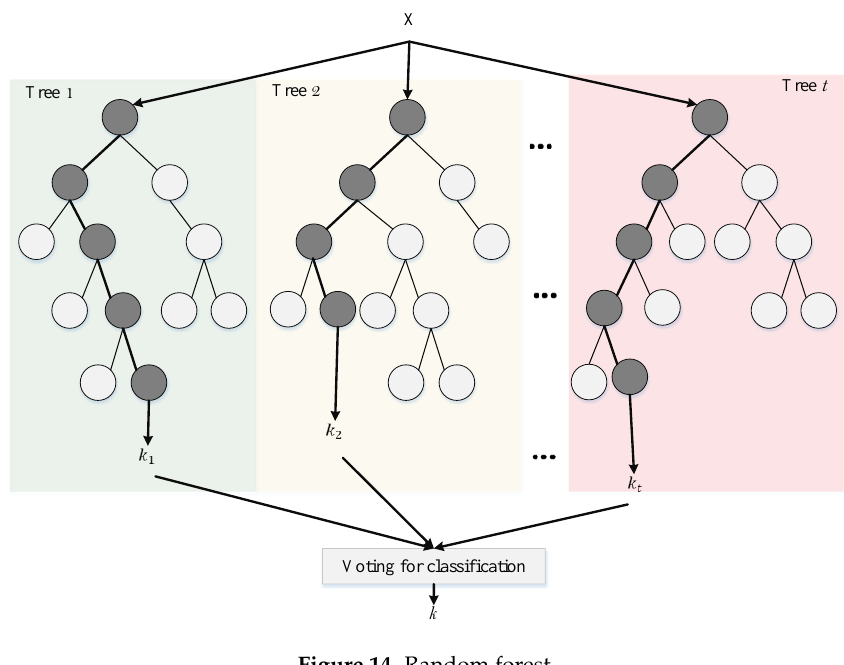
Figure 14. Random